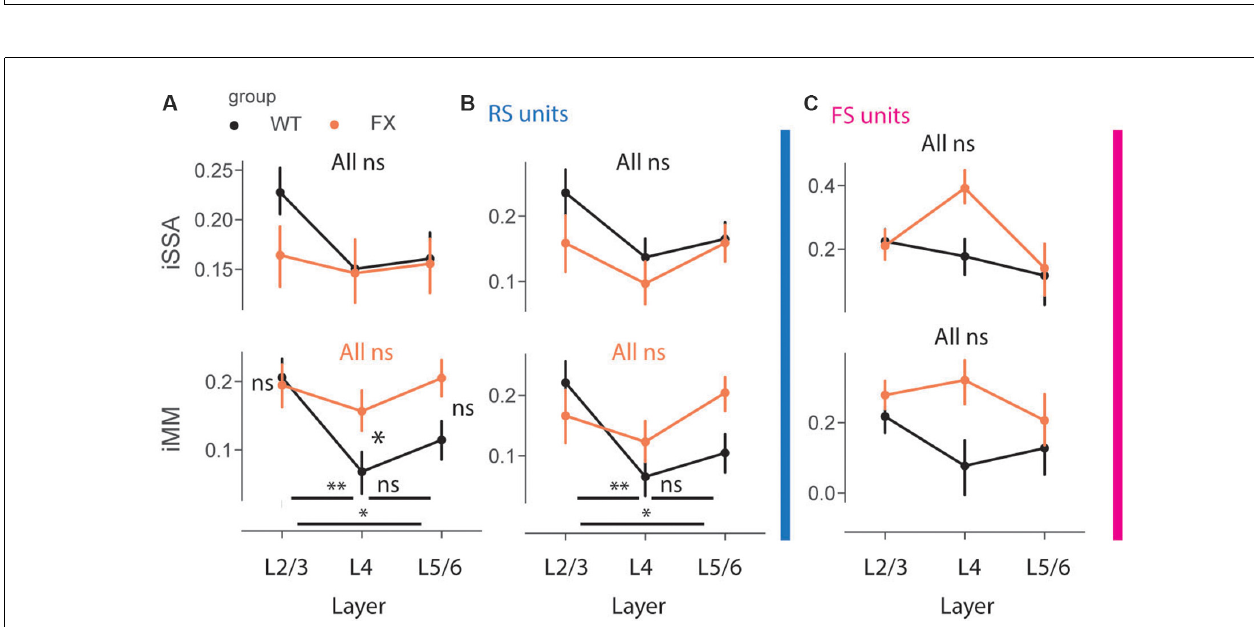
FIGURE 7 | Impaired laminar processing of MM responses in FX mice. (A) The point plots show iSSA and iMM magnitude for L2/3, L4, and L5/6 for WT vs. FX for all units. (B) Same as in (A) , but for RS units. (C) Same as in (A) , but for FS units. ∗ p < 0.05, ** p < 0.01, ns = not significant.